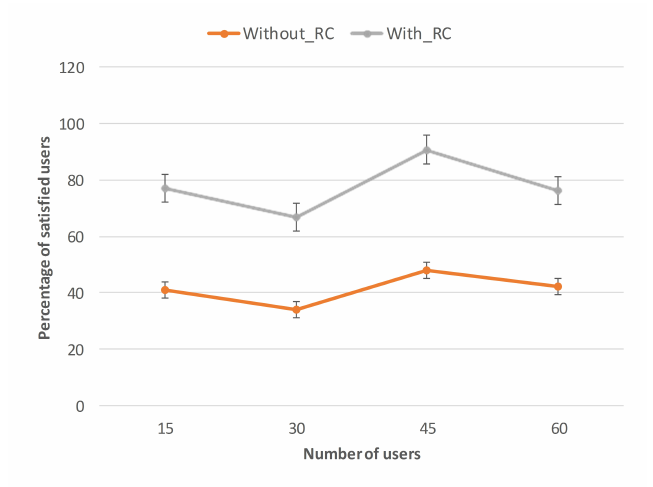
Figure 5. Percentage of satisfied users in terms of throughput.